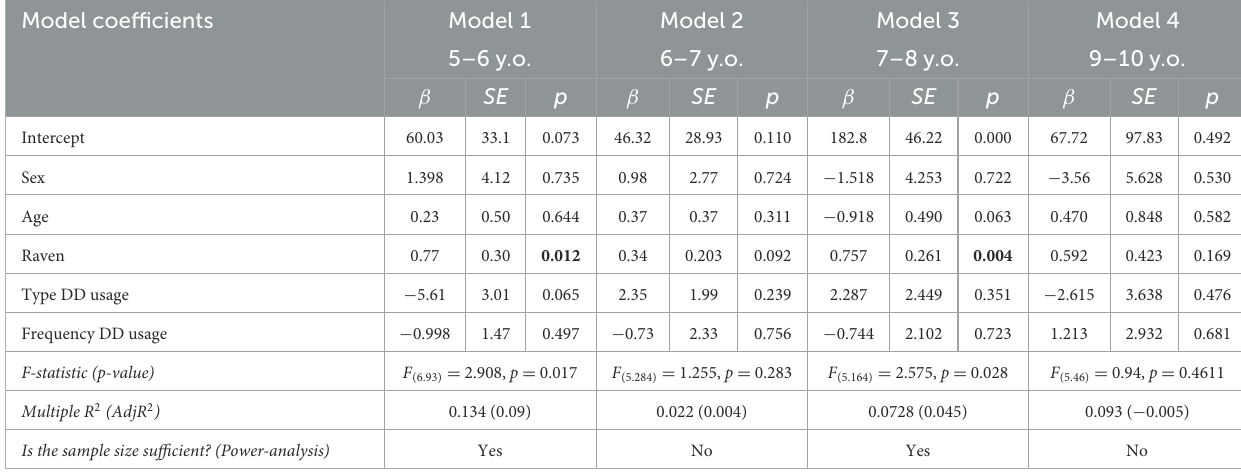
TABLE 3 Multiple linear regression analysis for the study variables predicting visual working memory from the senior kindergarten group to third school grade.